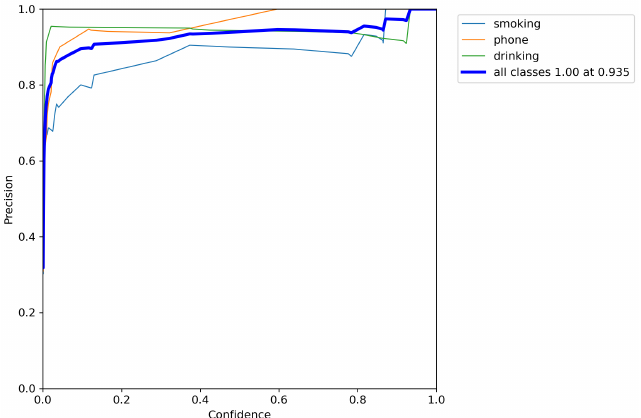
Figure 9. Recognition accuracy.